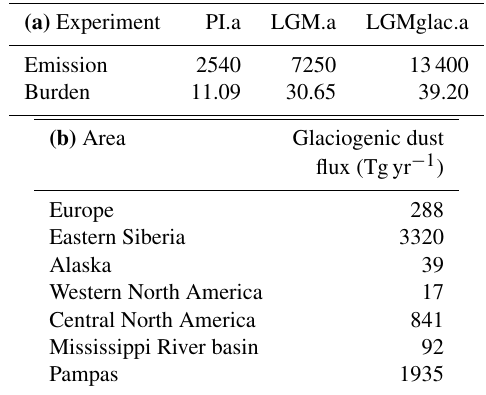
Table 1. (a) Simulated total dust emissions (Tgyr − 1 ) and atmo- spheric burden (Tg) for PI.a, LGM.a, and LGMglac.a. (b) Glacio- genic dust flux (Tgyr − 1 ) (Mahowald et al., 2006a) from the areas shown in Fig. S1 in the Supplement in longitudinal